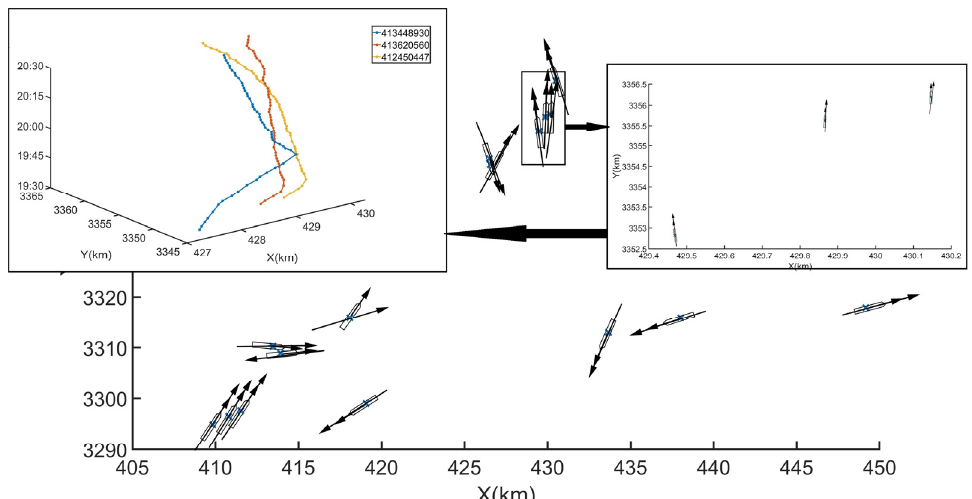
( e ) Figure 8. Position of two ships: ( a ) the two ships at 19:37; ( b ) the two ships at 19:41; ( c ) the two ships at 19:52; ( d ) the two ships at 20:00; ( e ) the two ships at 20:15. 3.2.2. Examples of Multi-Ship Encounter Situation Another time of 20:00:00, 24 October 2021, is selected according to the above method, and the data of the ships are filtered in the water area near Yangshan Port from AIS data. Then, further data are filtered, and their longitude and latitude data are converted into XY coordinates, so as to observe the ship positions and make subsequent judgments and